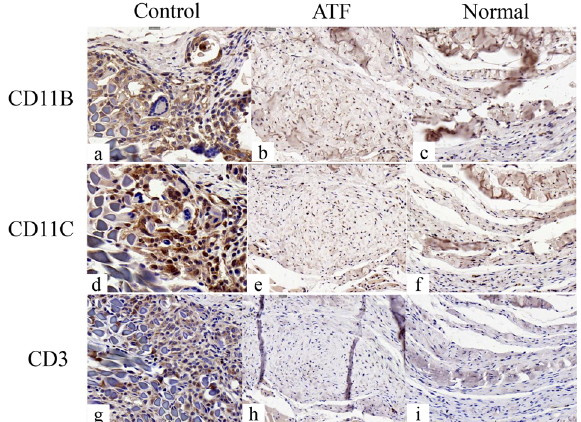
Fig. 6 Immunohistochemical staining results for immune in fl ammation factor of specimens in ATF and control group in SD rats. a – f Immunohistochemical test of neutrophils, monocytes, macro- phages, NK cell markers (CD11B and CD11C). Suture used in the surgery showed strongly positive ( a , d × 700), ATF material showed positive ( b , e × 500), and normal low back fascia collagen fi bers showed positive ( c , f × 500); g – i Immunohistochemical test of T cell markers (CD3). Suture used in the surgery showed strongly positive (g × 700), ATF material showed negative (h × 500), and normal low back fascia collagen fi bers showed negative (i ×